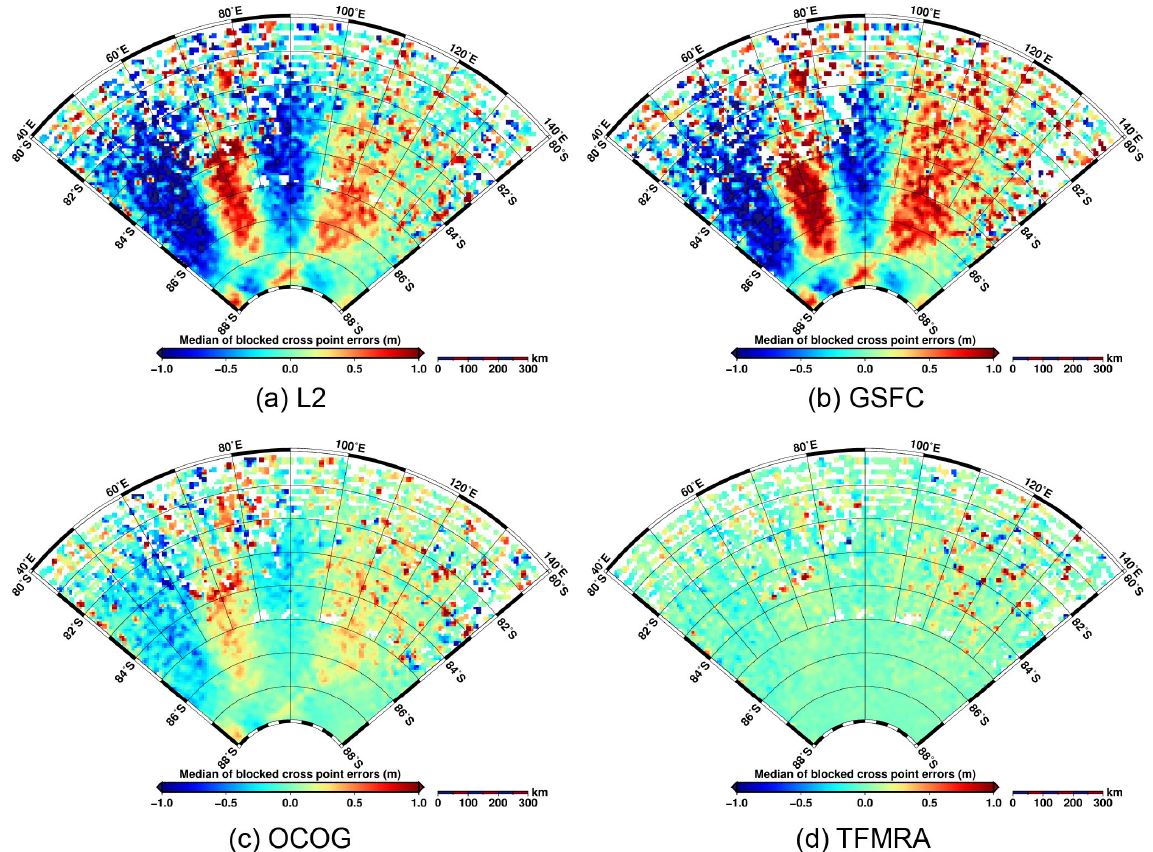
Figure 1. Results of the LRM crossover analysis in East Antarctica using different re-trackers. The threshold first maximum re-tracker (TFMRA) gives the best